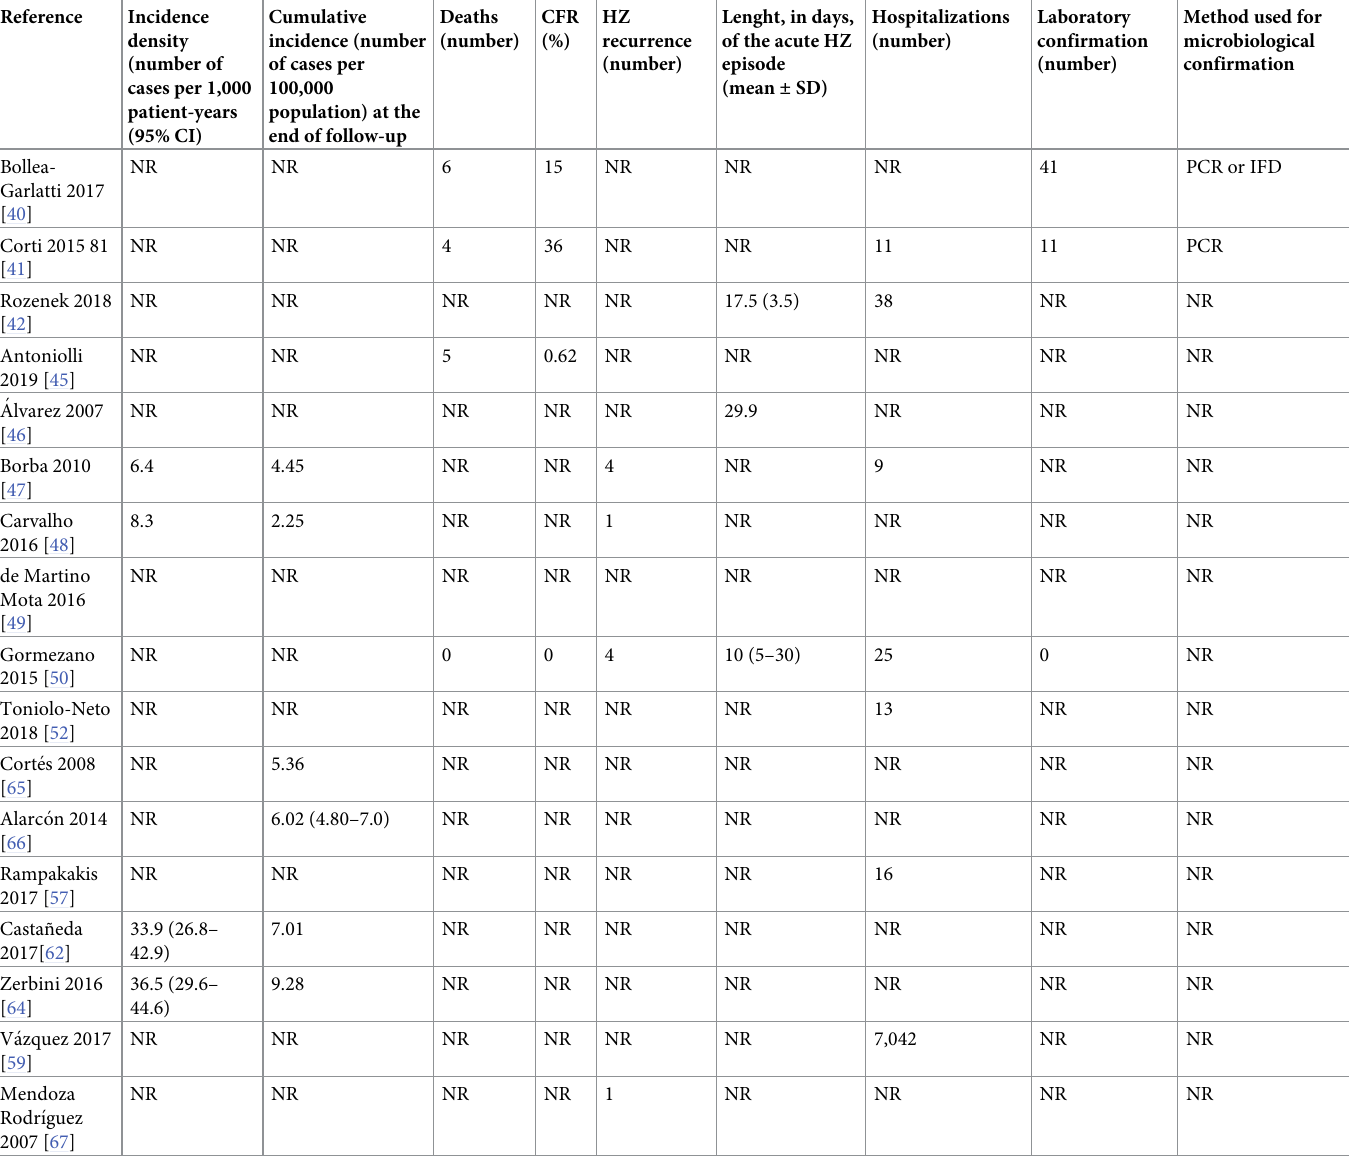
Table 3. Epidemiology and burden of HZ in